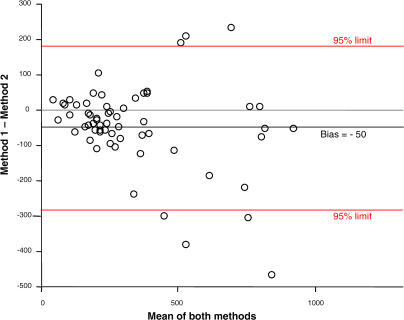
Methods Comparison and Correlation Studies for Absolute CD4 Counts in 61 Adults in BotswanaBland–Altman methods comparison plot comparing absolute CD4 cells per microliter of whole blood obtained by the microchip system as compared to standard four-color flow cytometry processed in parallel on a FACSCalibur in 61 HIV-infected adult participants. There is a proportional bias of −50 cells/μl relative to flow cytometry. Grey line indicates zero bias. Red lines indicate upper and lower 95% limits of agreement.